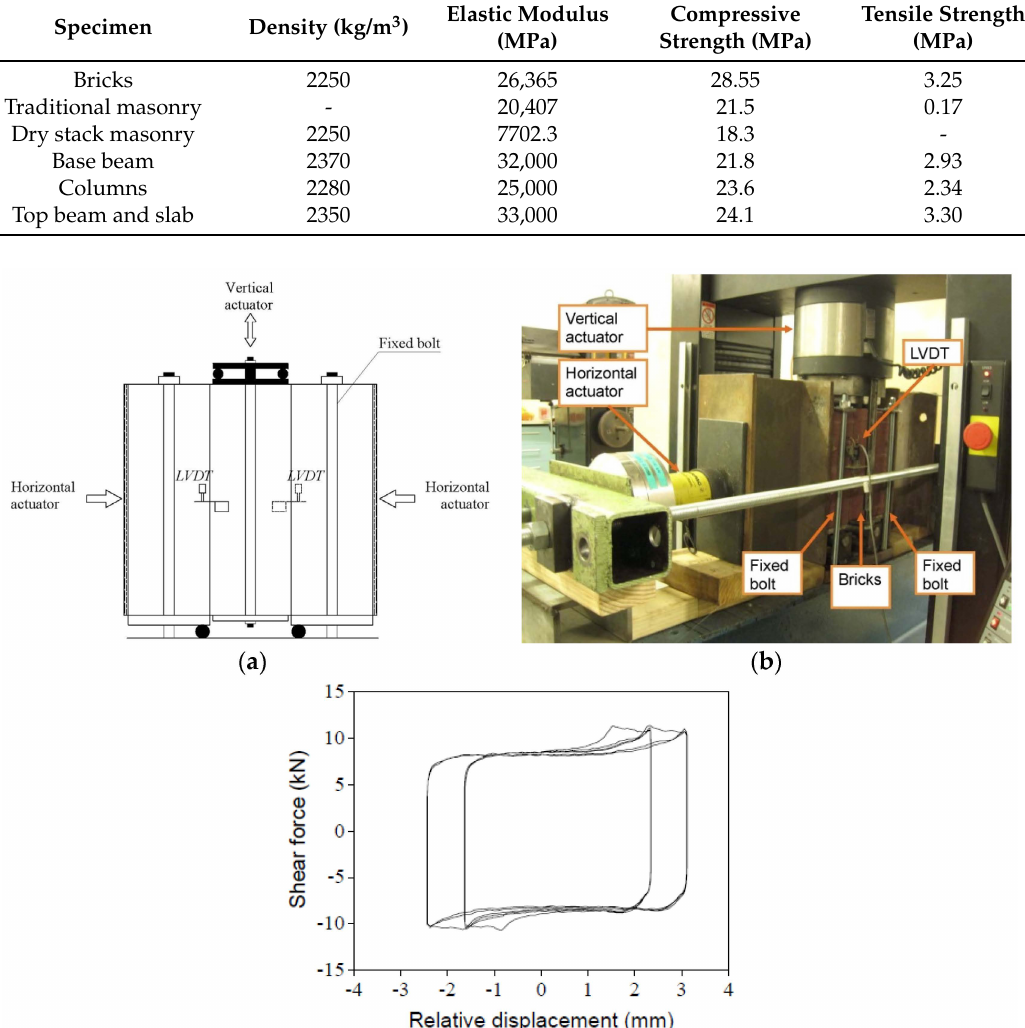
Table 1. Mechanical properties of the specimens.